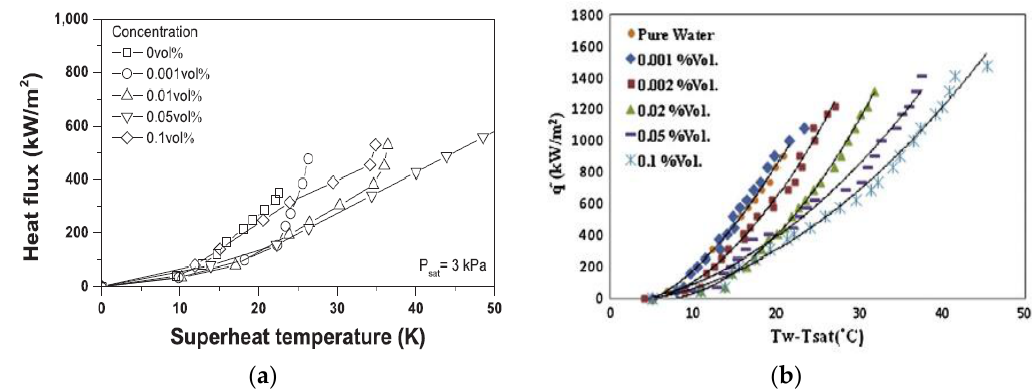
Figure 8. Boiling heat transfer curves and boiling heat transfer coefficient curves of different nanofluids. ( a ) Al 2 O 3 nanofluid boiling curve [74]. ( b ) Al 2 O 3 nanofluid boiling curve [78].